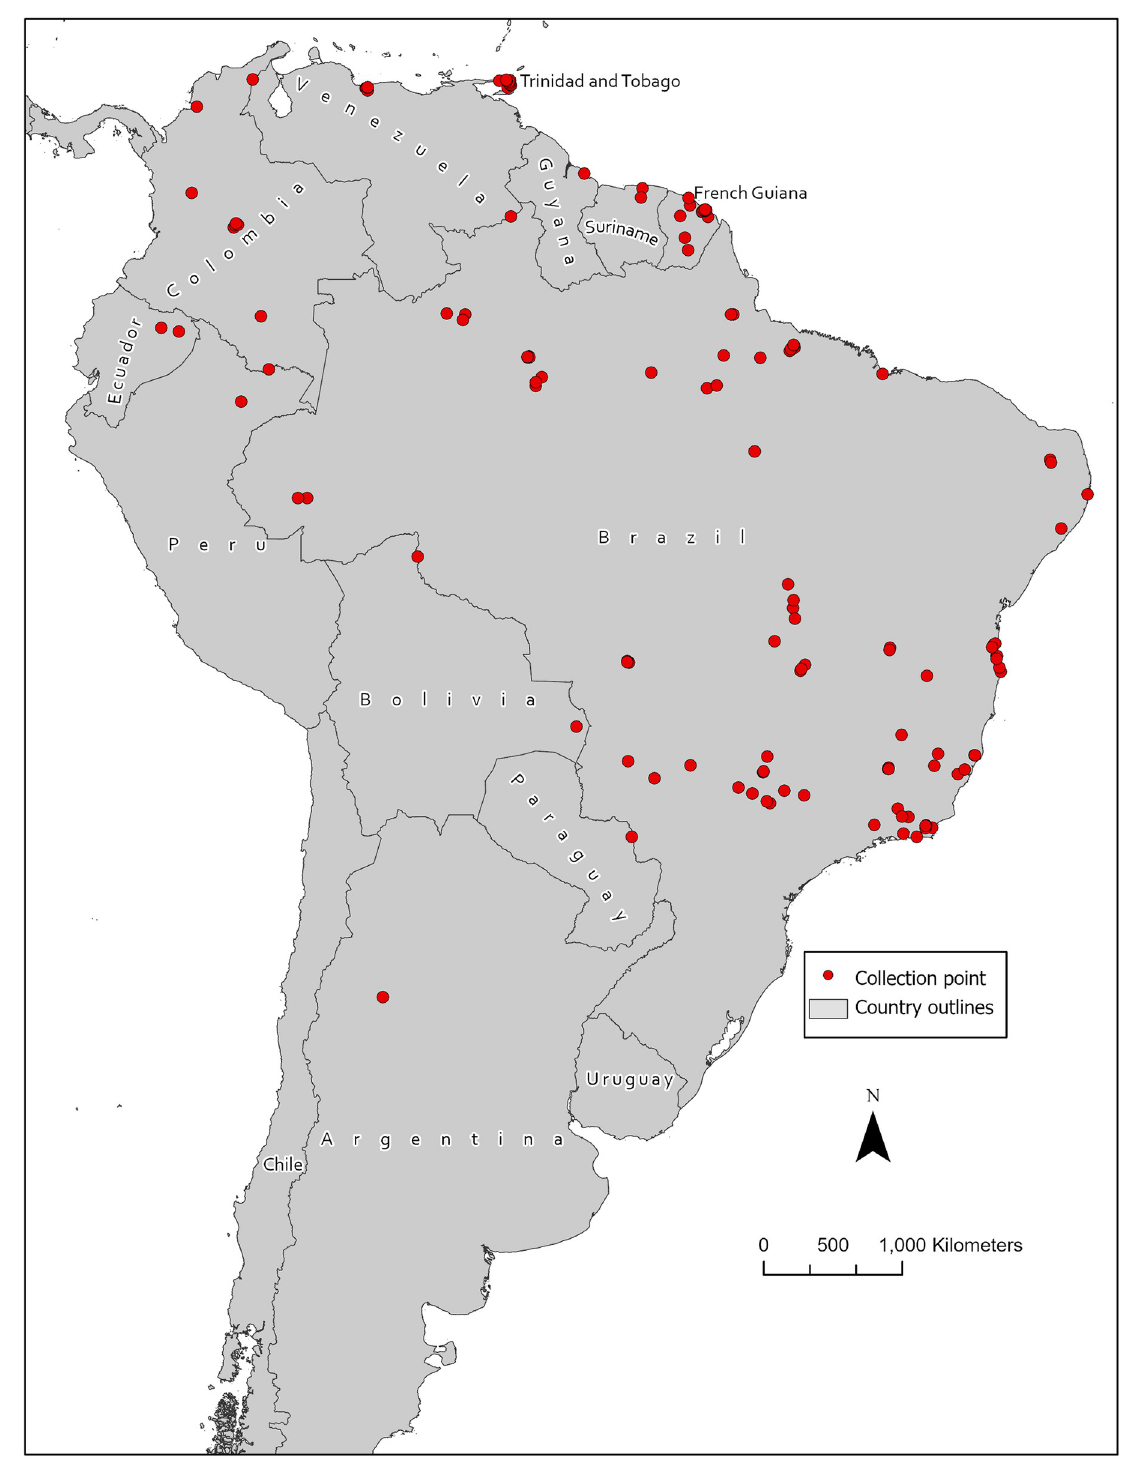
Fig 1. Geographic coordinates of Hg . janthinomys presence locations compiled during this study � . Base map sourced from Global Administrative Areas (GADM) version 4.0: https://gadm.org/download_country.html. � The Dataset compiled during the study underwent spatial thinning and remaining records were divided into training and testing